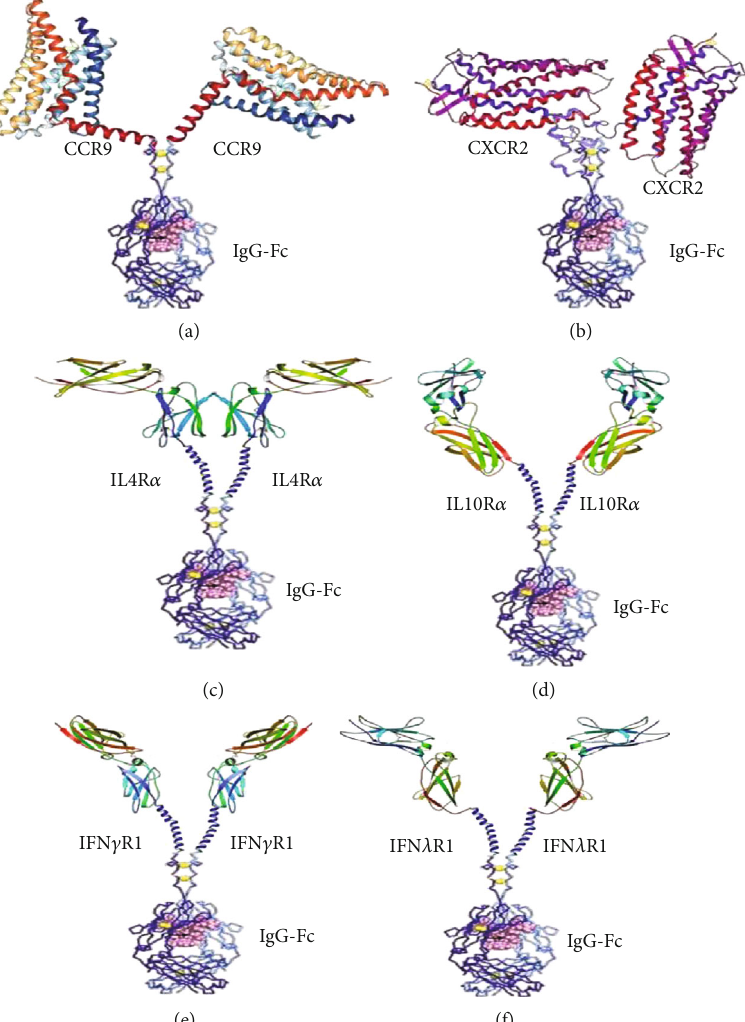
Figure 1: Shows a design for Fc-fused QTY receptors: (a) CCR9QTY-Fc; (b) CXCR2QTY-Fc; (c) IL4R α QTY-Fc; (d) IL10R α QTY-Fc; (e) IFN γ R1QTY-Fc; (f) IFN λ